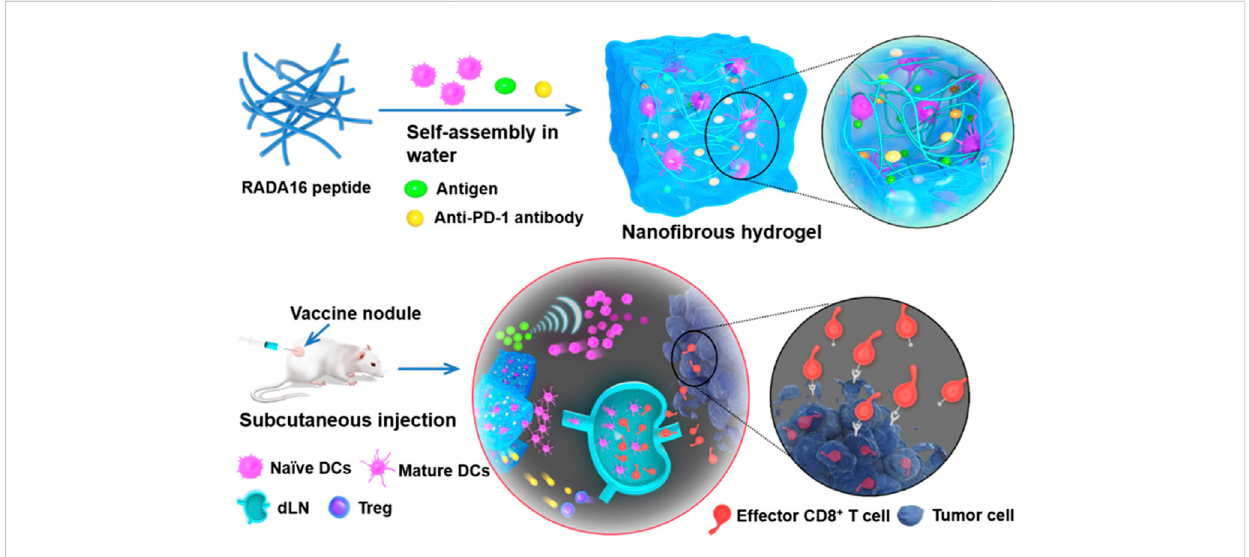
FIGURE 4 DeliveryofexogenousdendriticcellsandPD-1inRADA16 forimmunotherapyvaccine.ReprintedwithpermissionfromYangetal.(2018).Copyright 2018 American Chemical